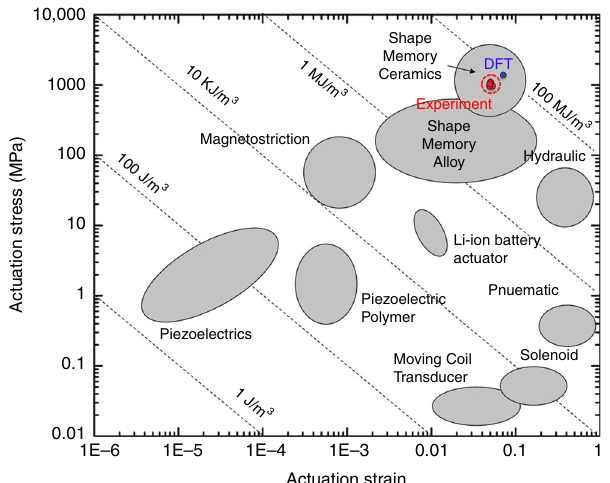
Fig. 3 A comparison of CaFe 2 As 2 with other structural and actuator materials. Actuator stress and strain for various actuator materials and systems. Contours of constant speci fi c work are indicated by dashed lines (adapted from Lai et al. 11 , Huber et al. 26 and Lang et al. 27 ). Both experimental and DFT data are included. All four experimental data came from stress – strain curves in Supplementary Fig. 3c. Note that CaFe 2 As